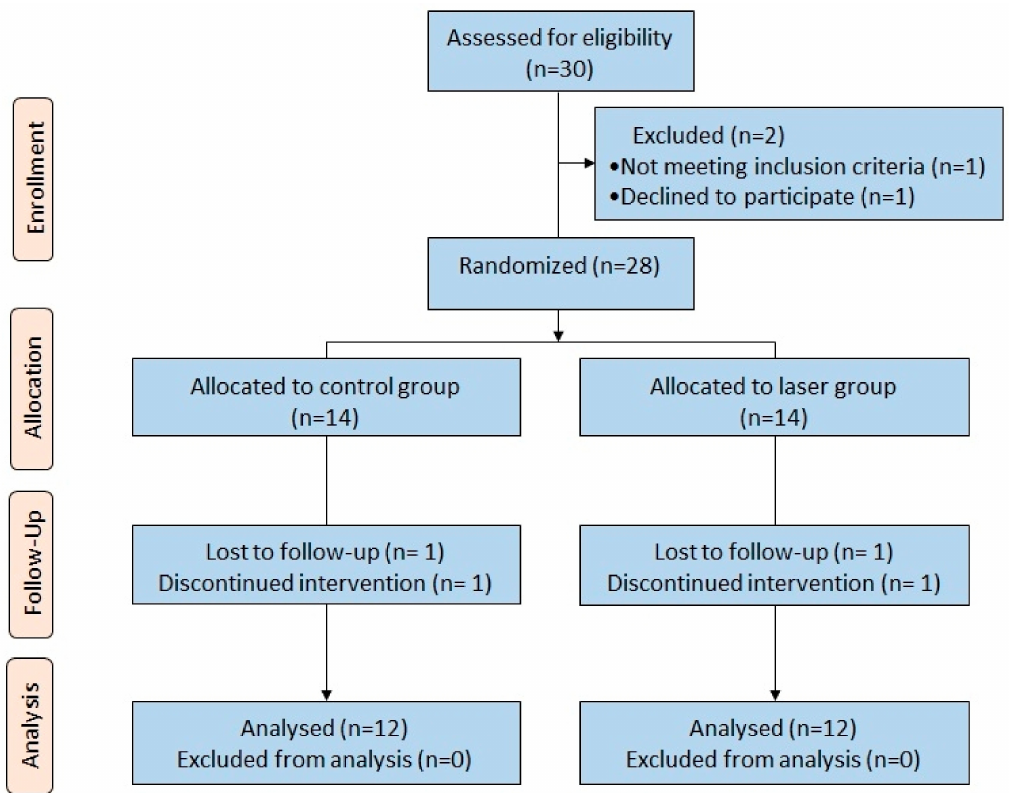
Figure 8. Flow chart of the study